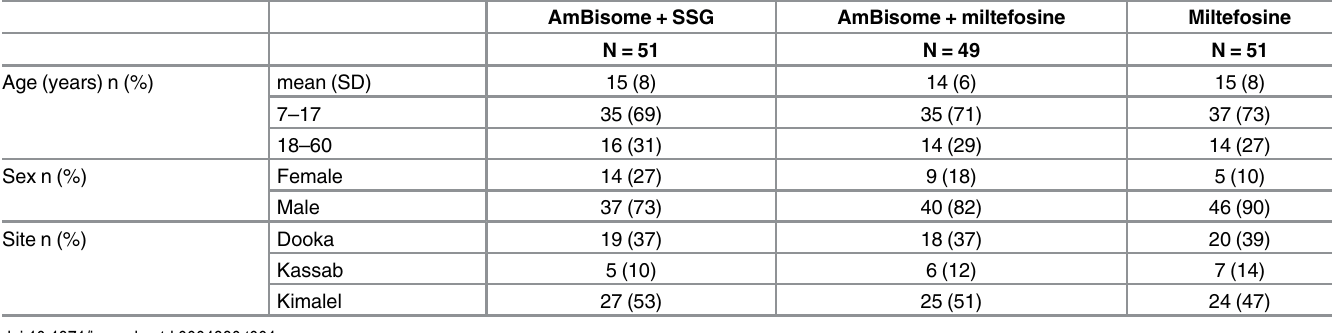
Table 1. Baseline demographic